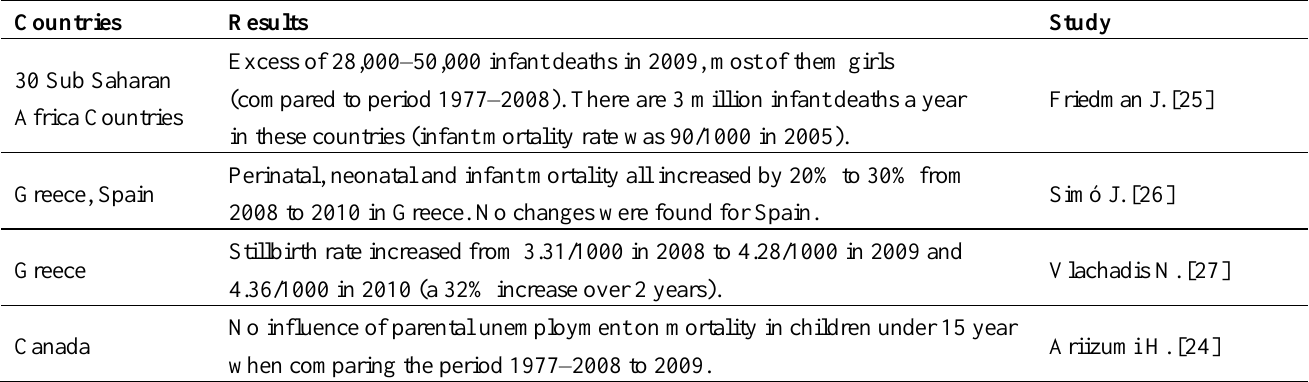
Table 2. Impact of the 2008 economic crisis on infant and child